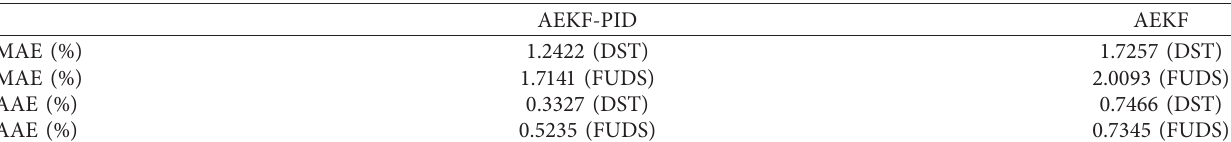
Table 1: SOC estimation